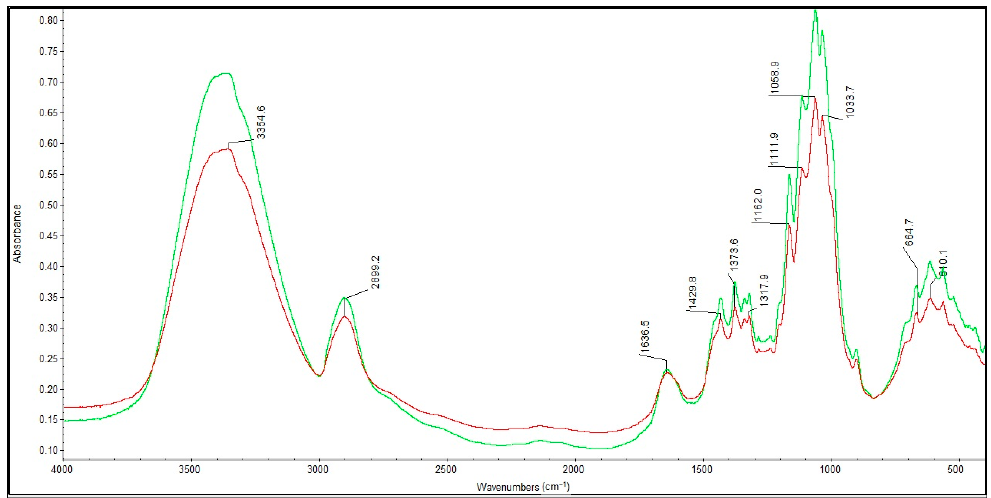
Figure 10. FTIR spectra of the sterilized impregnated gauze before and after the accelerated ageing: − initial; − after one year of simulated ageing.